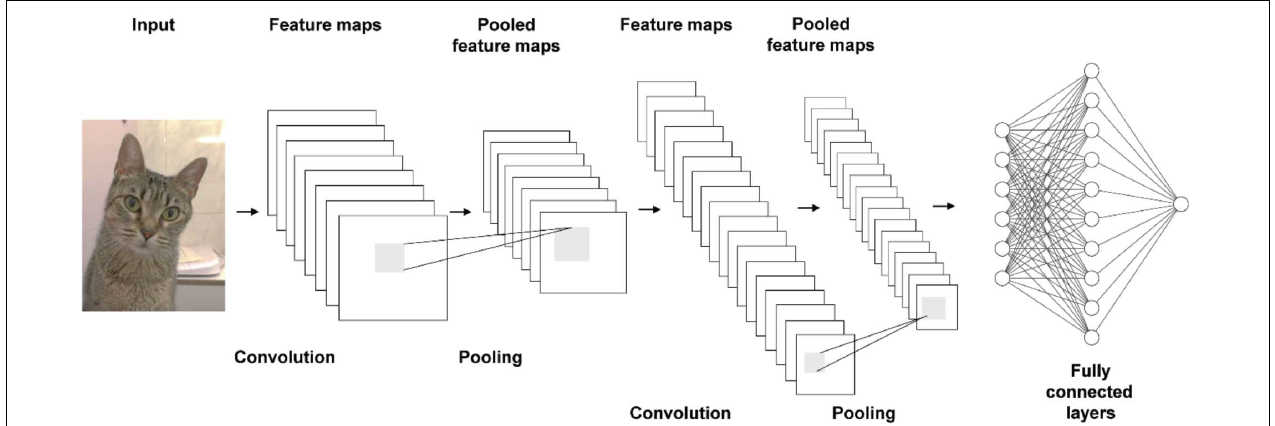
FIGURE 2 | General architecture of a CNN.